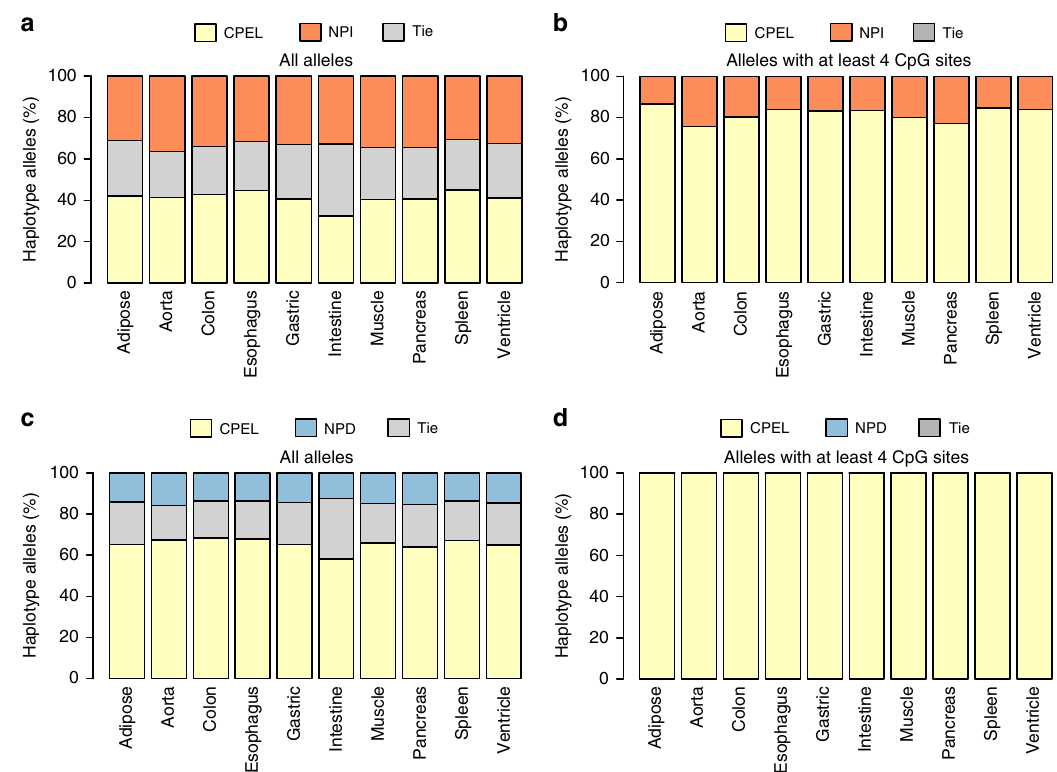
Fig. 4 Evaluation of model fi t to the real data. Stacked histograms showing the percentage of haplotype alleles for which the CPEL model is more preferable (Akaike weight > 0.5), equally preferable (Akaike weight = 0.5), or less preferable (Akaike weight< 0.5) than the NPI or the NPD model. A total of 1,766,467 haplotype alleles have been considered. The results demonstrate the superiority of the CPEL model for fi tting real WGBS data when compared to the NPI and NPD models, especially within haplotype alleles that contain at least four CpG sites. a Comparison between the CPEL and the NPI models based on all alleles. b Comparison between the CPEL and the NPI models based on alleles with at least four CpG sites. c Comparison between the CPEL and the NPD models based on all alleles. d Comparison between the CPEL and the NPD models based on alleles with at least four CpG sites.